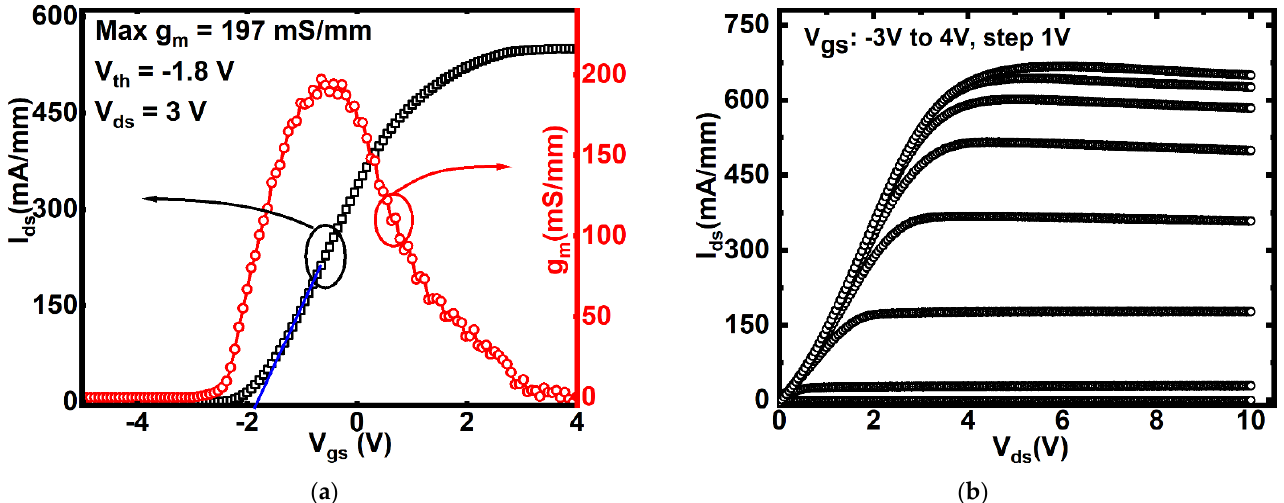
Figure 2. ( a ) Transfer characteristics at V ds = 3 V; ( b ) output characteristics as V gs increases from − 3 V to 4 V with a step of 1